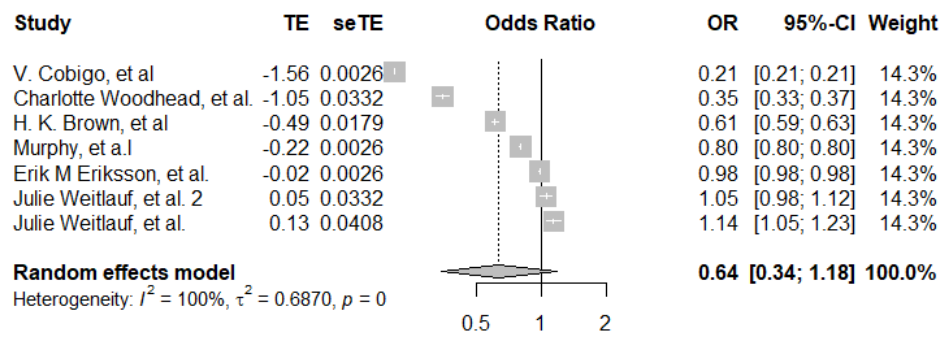
Figure 6. Pooled adjusted odds ratio estimates of cervical cancer screening uptake by psychosocial disability status [26,29–31,34,36]. Table 4. Summary of subgroup